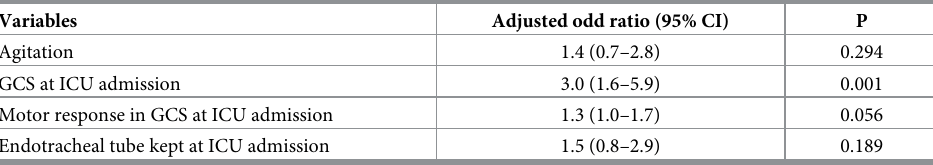
Table 8. Risk factors for longer hospital length of stay (adjusted